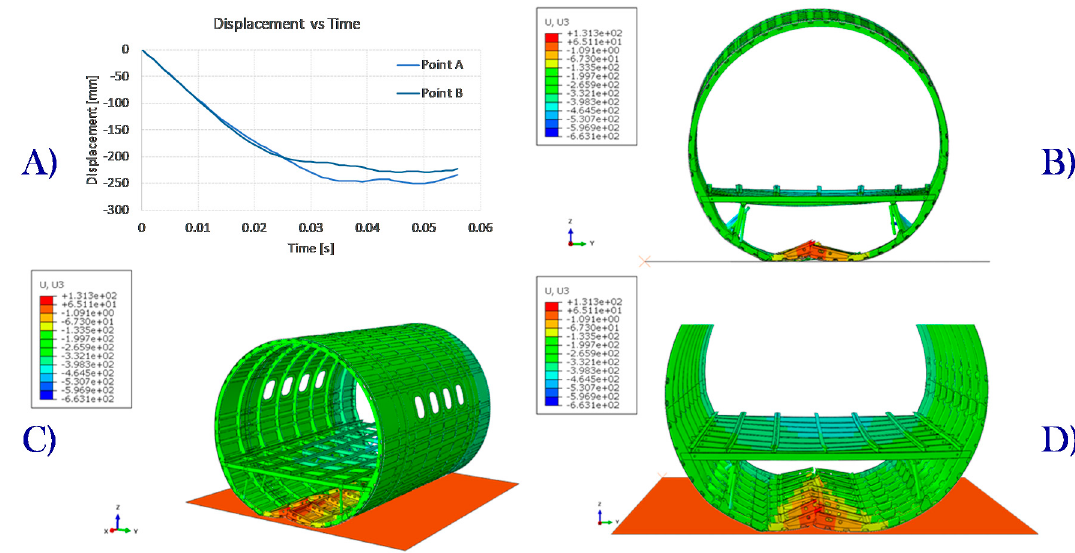
Figure 9. ( A ) Displacement vs. time. ( B ) Frontal view. ( C ) Isometric view. ( D ) Cargo area